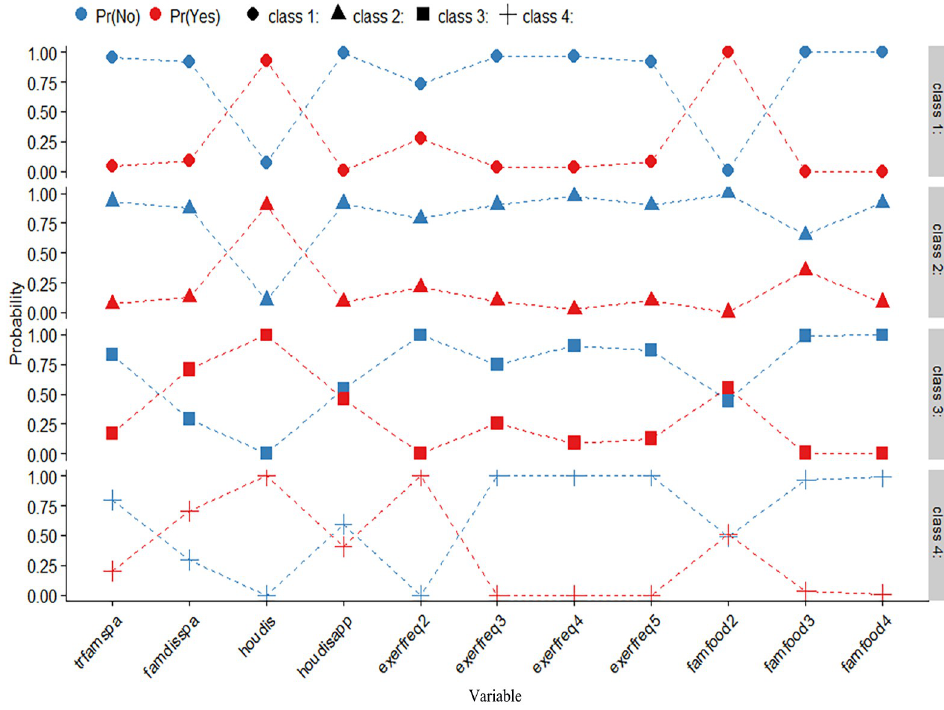
Fig 5. Conditional probability distributions of manifest variable responses by class.